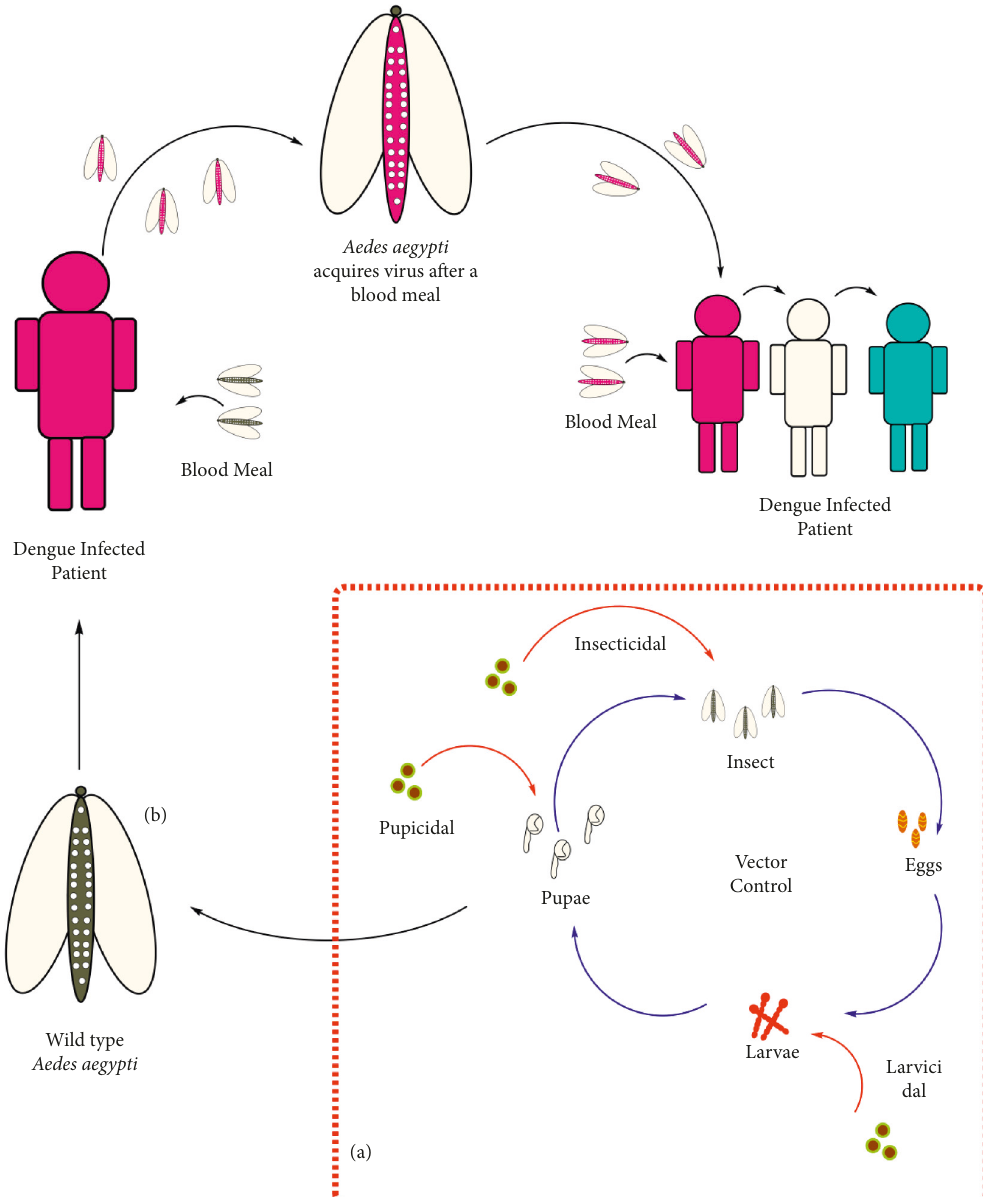
Figure 3: Vector control and dengue